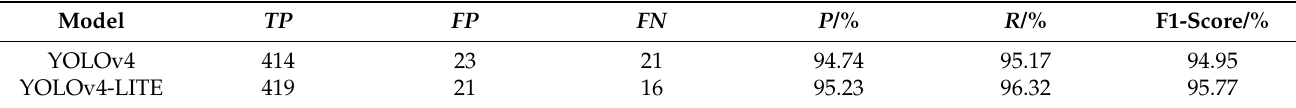
Table 3. Validation set test results after network improvement (conf-thresh = 0.5, IoU = 0.5).